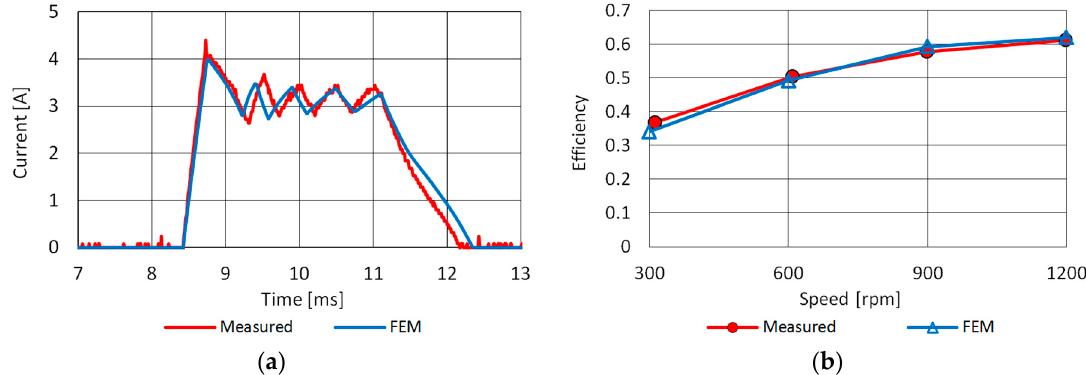
Figure 7. ( a ) Comparison of measured and calculated phase current, θ on = 0°, θ off = 19.25°, speed is 1200 rpm, DC-link voltage is 100 V, load torque is 1 Nm; ( b ) measured and calculated motor efficiency for constant angles θ on = 0°, θ off = 17.6°, mechanical and power converter losses are included.